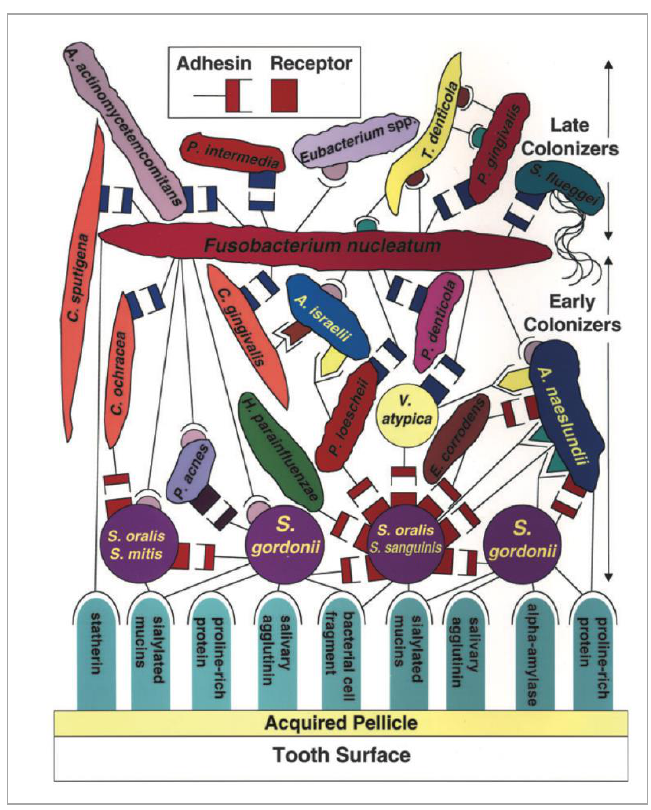
Figure 2. Intergeneric coaggregation among oral bacteria [64].